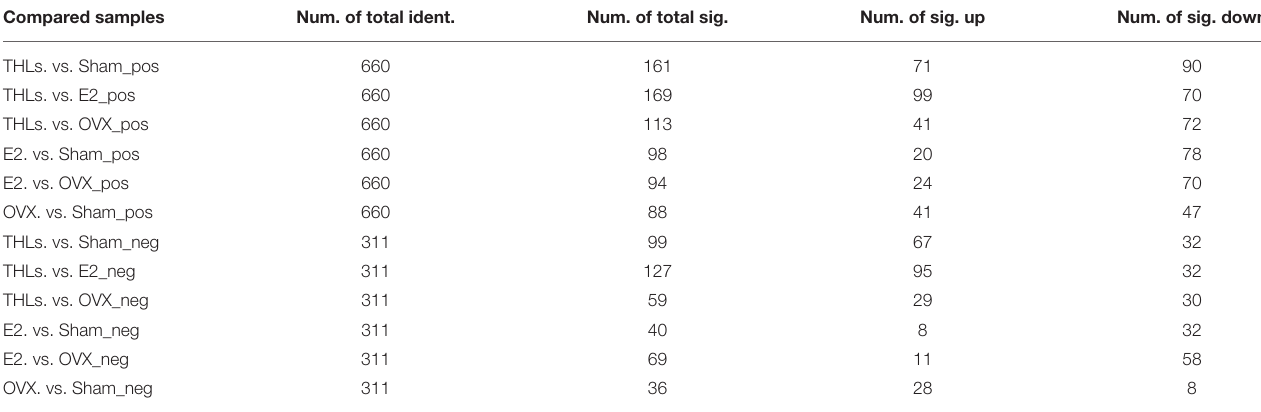
TABLE 3 | Results of differential metabolites screened between groups. Compared samples Num. of total ident. Num. of total sig. Num. of sig. up Num. of sig.